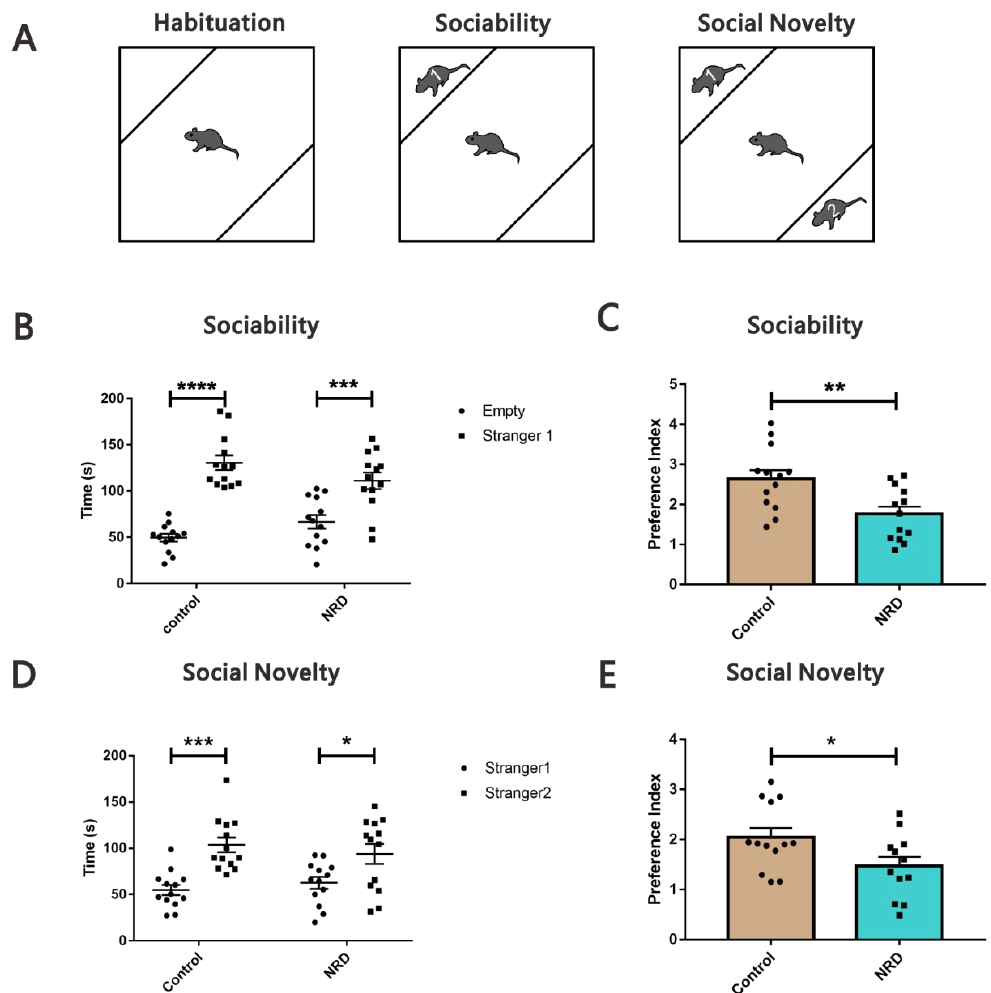
Figure 9. Both social behavior and social novelty behavior were impaired in NRD mice. ( A ) Diagram of the social novelty test. ( B ) Sniffing time of empty and stranger 1in the control and NRD mice during sociability session. * p < 0.05, *** p < 0.001, as determined by the two-way ANOVA. ( C ) Quantitative sociability assessment. ** p < 0.01 as determined by unpaired Student’s t -test. ( D ) Sniffing time of stranger 1 and stranger 2 in the control and NRD mice during social novelty session. *** p < 0.001, **** p < 0.0001, as determined by the two-way ANOVA. ( E ) Quantitative social novelty assessment. * p < 0.05 as determined by unpaired Student’s t -test. Data are expressed as the means ± SEMs. n (control) = 13, n (NRD) = 13.